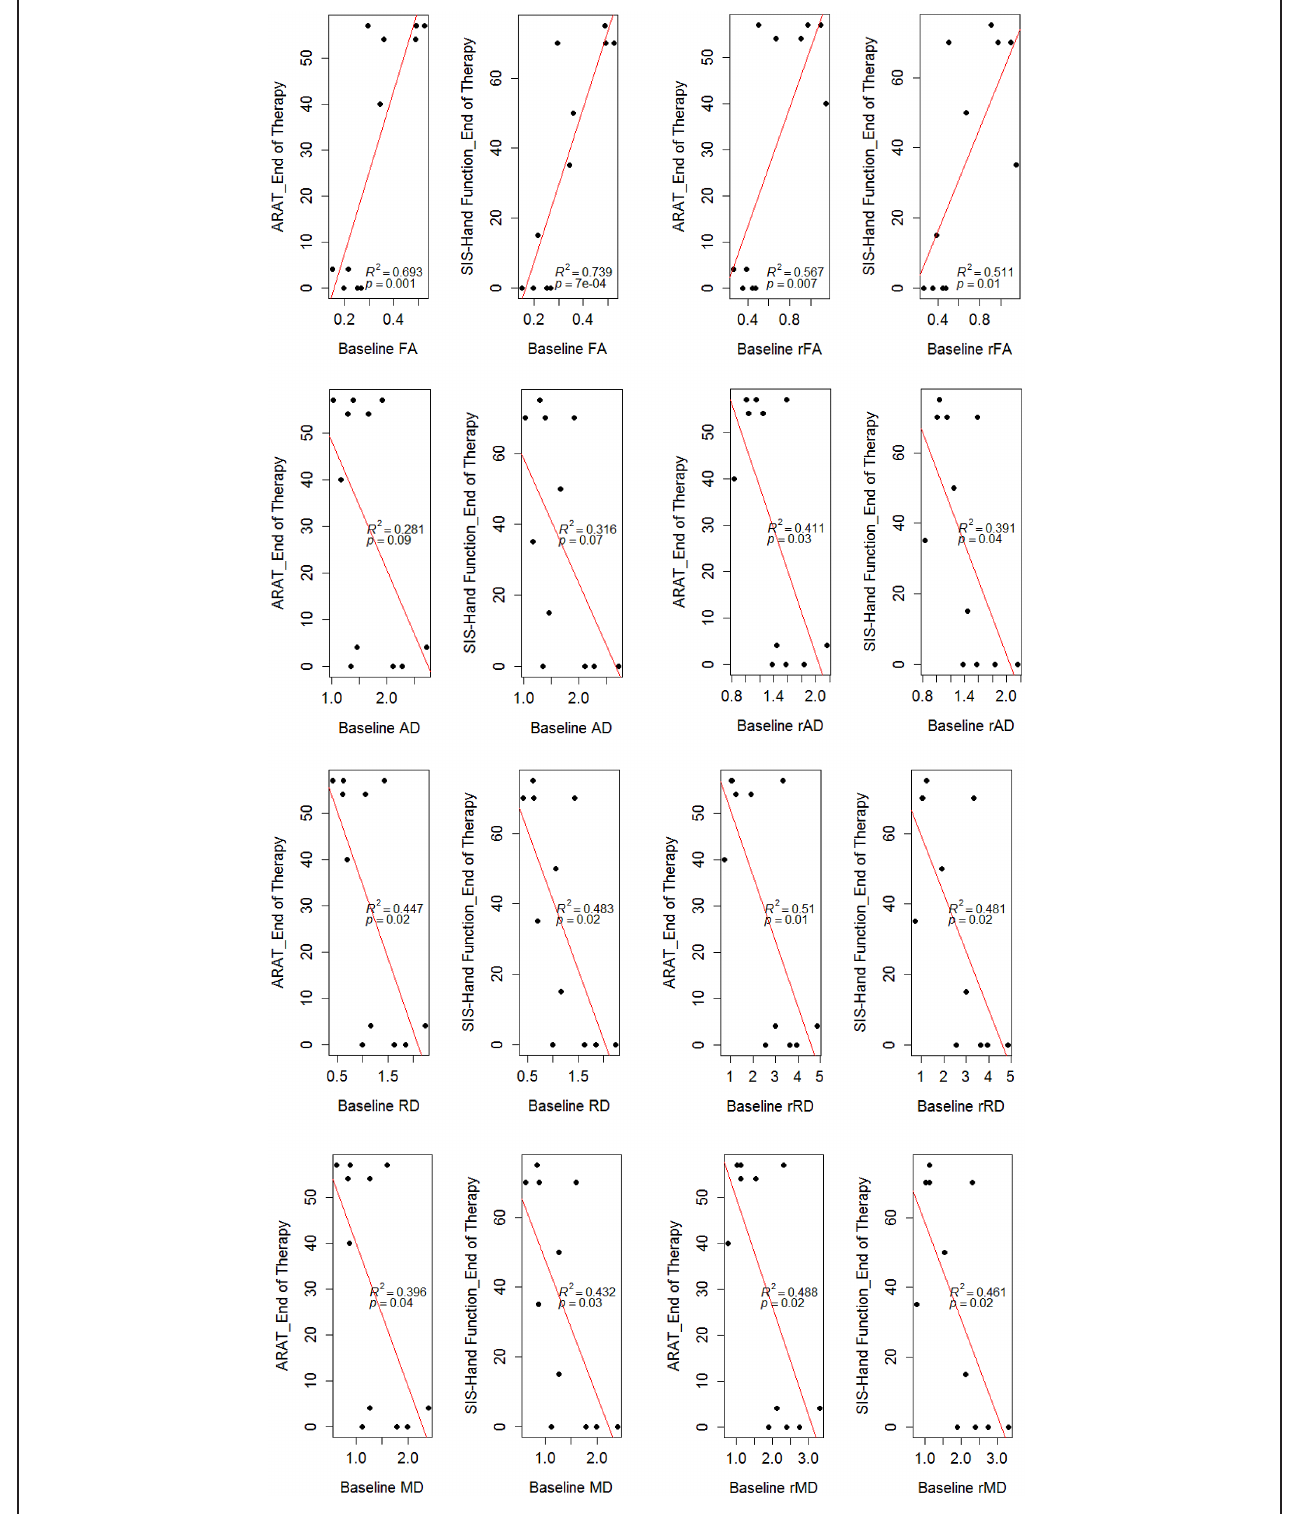
FIGURE 6 | Correlation of baseline DTI measures and motor outcomes evaluated immediately post-intervention. Baseline DTI measures (i.e., evaluated at immediately pre-intervention) correlated with motor outcomes measured immediately post-intervention. R -squared